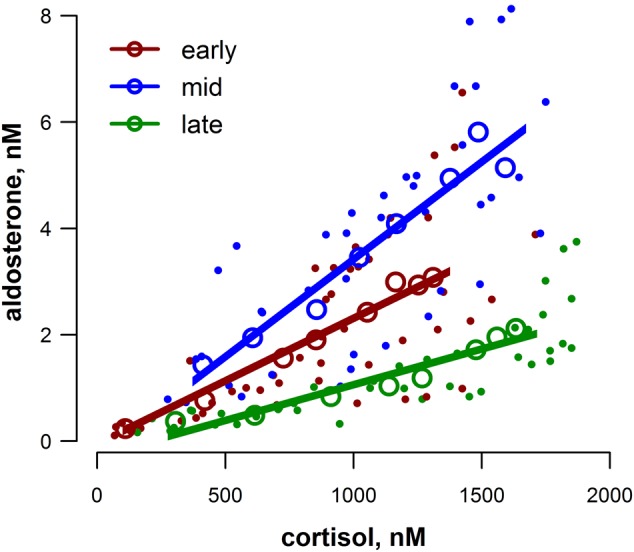
Cortisol and aldosterone concentrations were tightly correlated during the stress response [linear mixed model (LMM), F1,113 = 237.5, P < 0.0001], and this relationship varied by study group (cortisol × state, F2,113 = 17.1, P < 0.0001); see main text for further description of statistical analysis. Each sample collected in this study for all study animals is represented by filled symbols and colour coded according to moulting state (early, mid or late). Fitted regression lines are derived from the LMM model fits, and marginal r2 (mr2) values are shown for each group. Open circles are average hormone values at each sampling time (0–150 min) within the study group and are shown for visual clarity only.